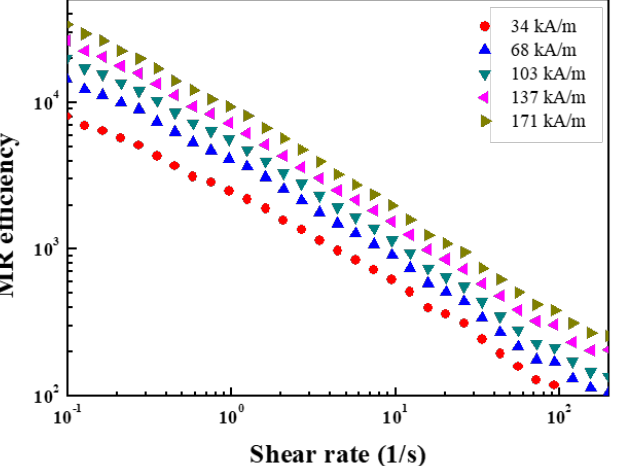
. γ under different H